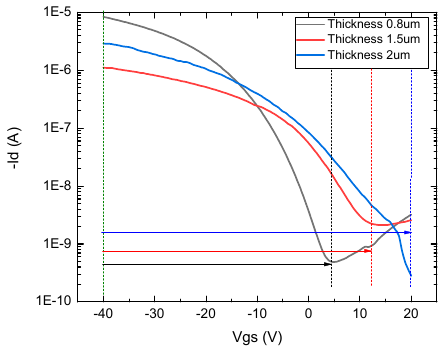
Figure 8. Transfer characteristics of three fully printed CNT TFTs on Kapton with different thicknesses of 2:1 wt.% cross-linked PVP dielectrics (L = 80 µm; W = 500 µm). The devices with thin dielectric layers were characterized, and Figure 9a,b show the